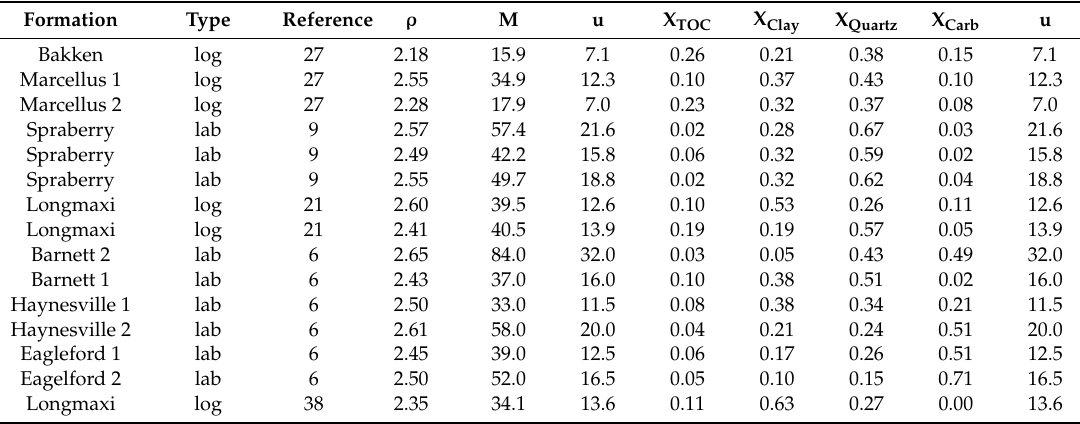
Table 6. Literature data used for validation. These data are from di ff erent formations than those included in our database, or from the same formation but from di ff erent localities, or acquired in the laboratory; each instance thereby constituting an out-of-sample test. Moduli are in GPa, density is in gm / cc, and volume fractions are normalized to sum to